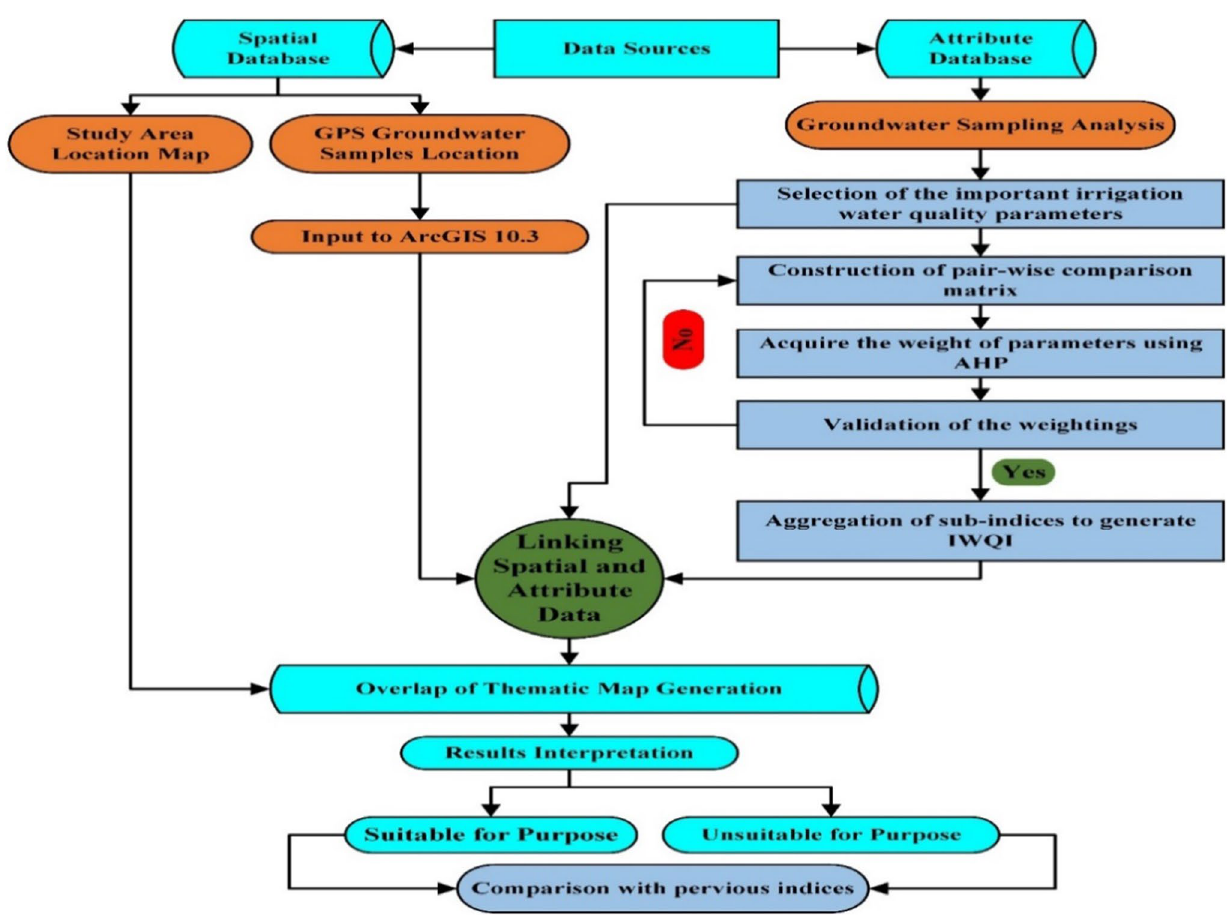
Fig. 3 Methodology flowcharts of the new approach (IWQI)